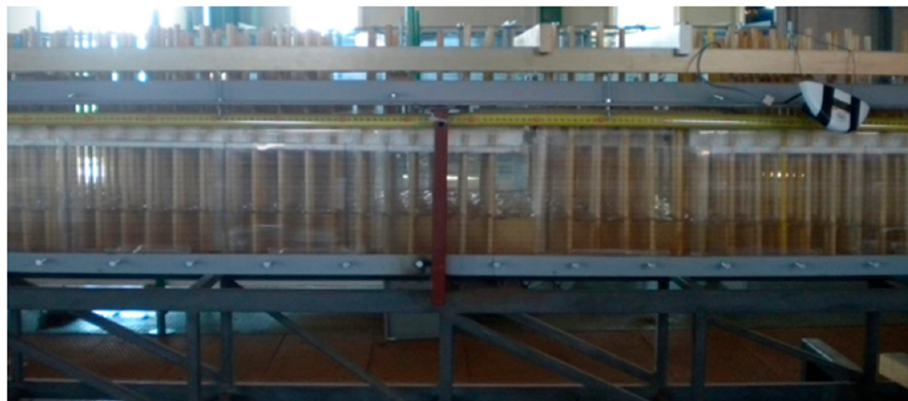
Figure 1. Hydraulic flume.